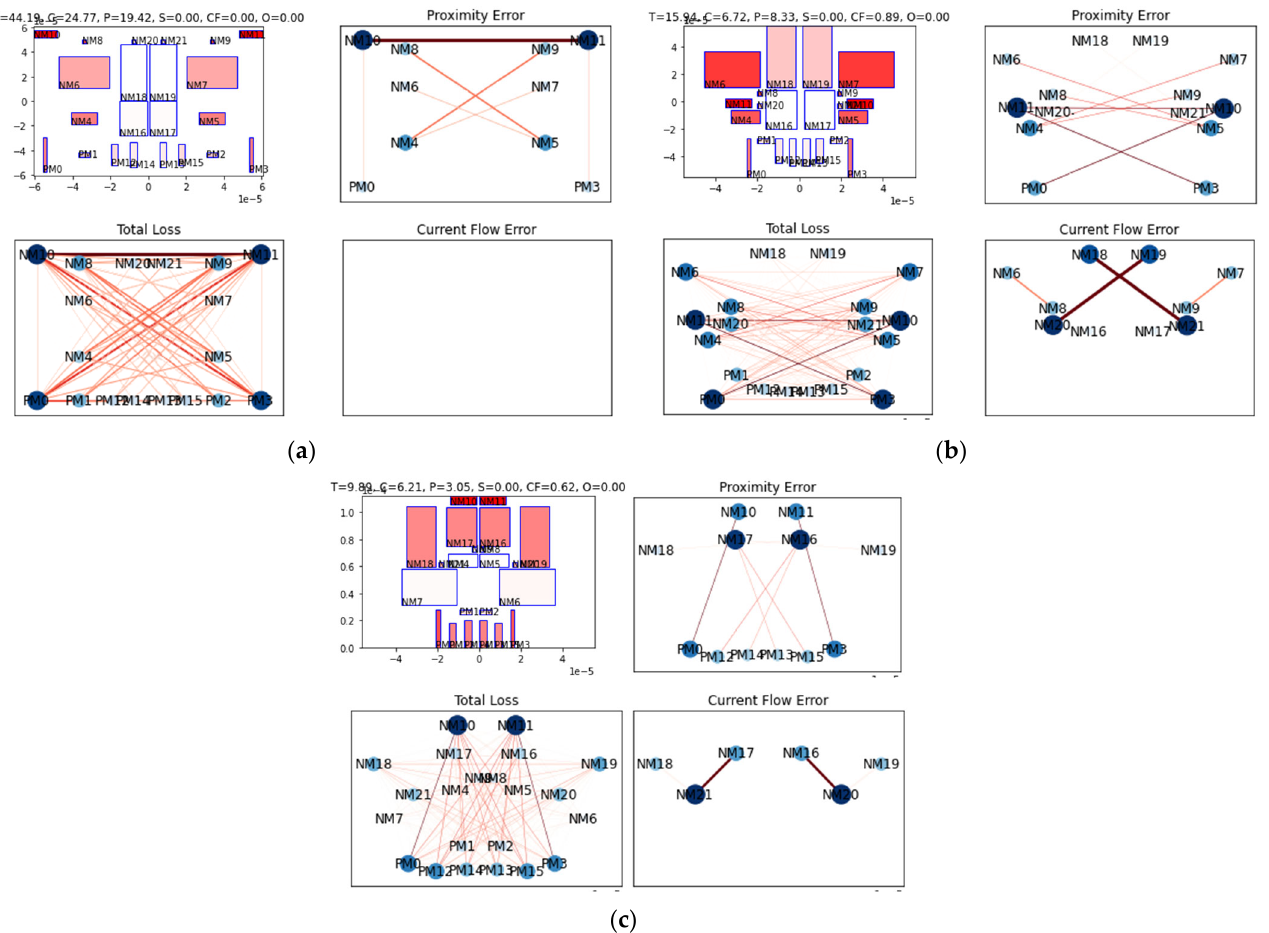
Figure 4. Placements generated by Virtuoso XL, a human designer and the proposed toolbox, along with the total, the proximity and the current ‐ flow error graphs. ( a ) Cadence generated placement. ( b ) Human designed placement. ( c ) Toolbox’s generated Table 1. Floorplans’ error comparison for the current starving single ‐ stage amplifier biased by voltage ‐ combiners.